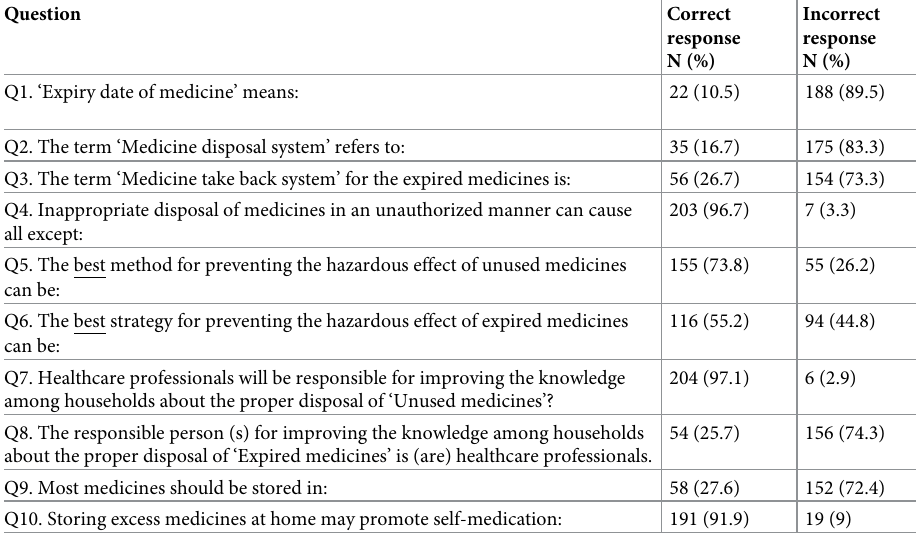
Table 2. Correct and incorrect responses for knowledge